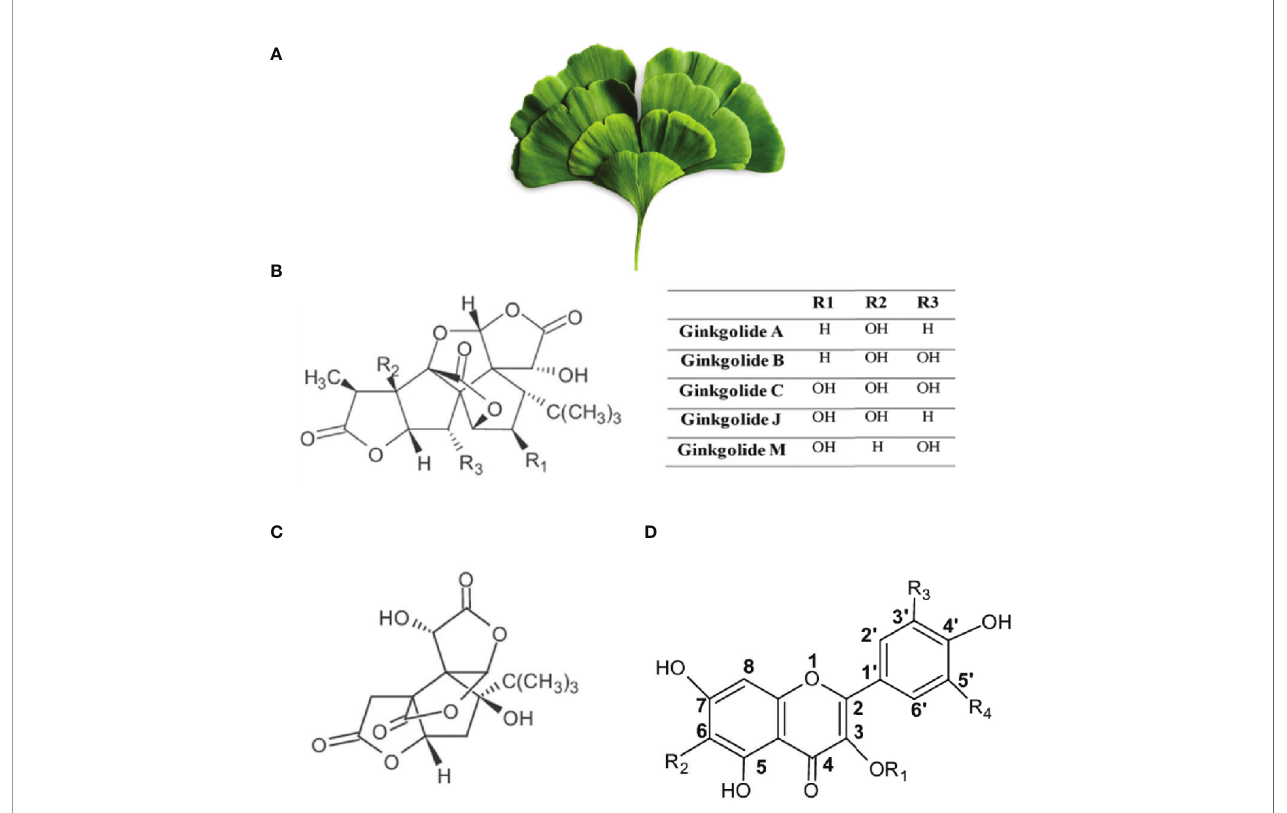
FIGURE 3 | Ginkgo biloba . (A) Leaves of Ginkgo biloba or Maiden Hair Tree (from https://pngtree.com/freepng). (B) Chemical structure of Ginkgolides. (C) Chemical structure of Bilobalides. (D) Structural skeleton of fl avonoids. R1 and R2 are side